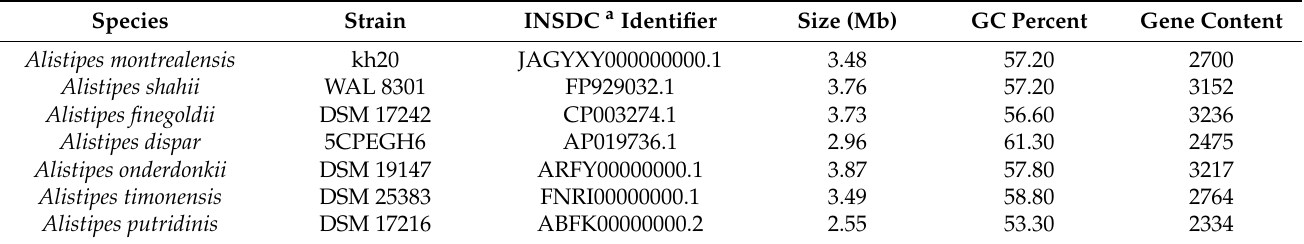
Table 4. Genome comparison of closely related species to strain kh20 T .